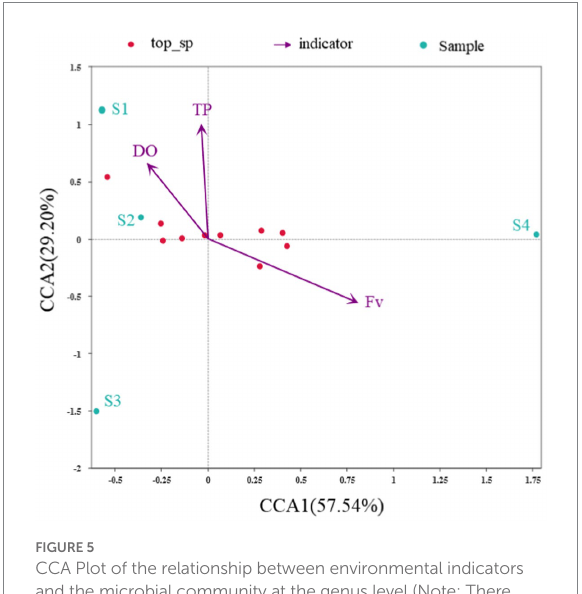
FIGURE 5 CCA Plot of the relationship between environmental indicators and the microbial community at the genus level (Note: There were too many indicators associated with the microbial community, many of which were autocorrelated. Therefore, only the environmental indicators that have a greater impact on the microbial community were